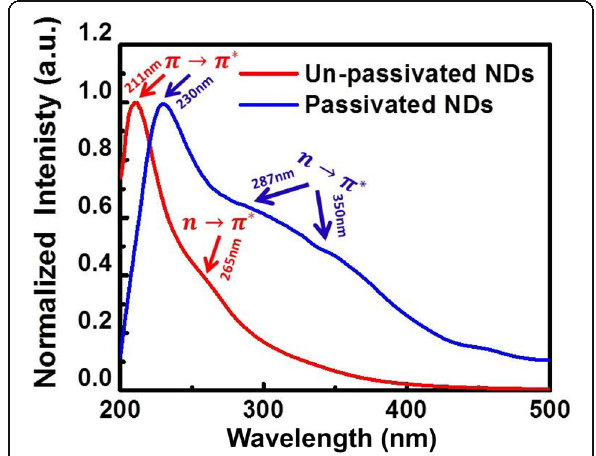
Fig. 4 UV-Vis absorption spectra of un-passivated and passivated